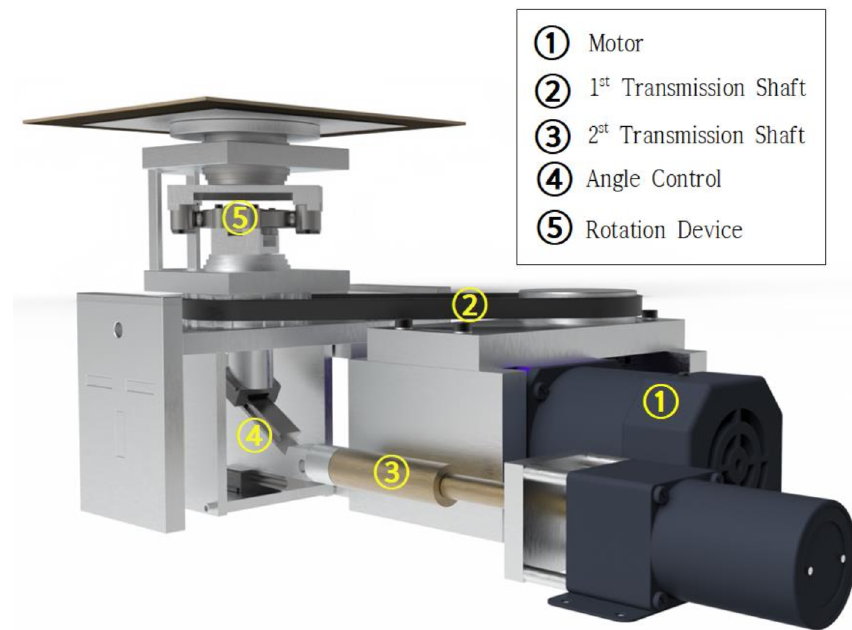
Figure 8. Device (simulator)